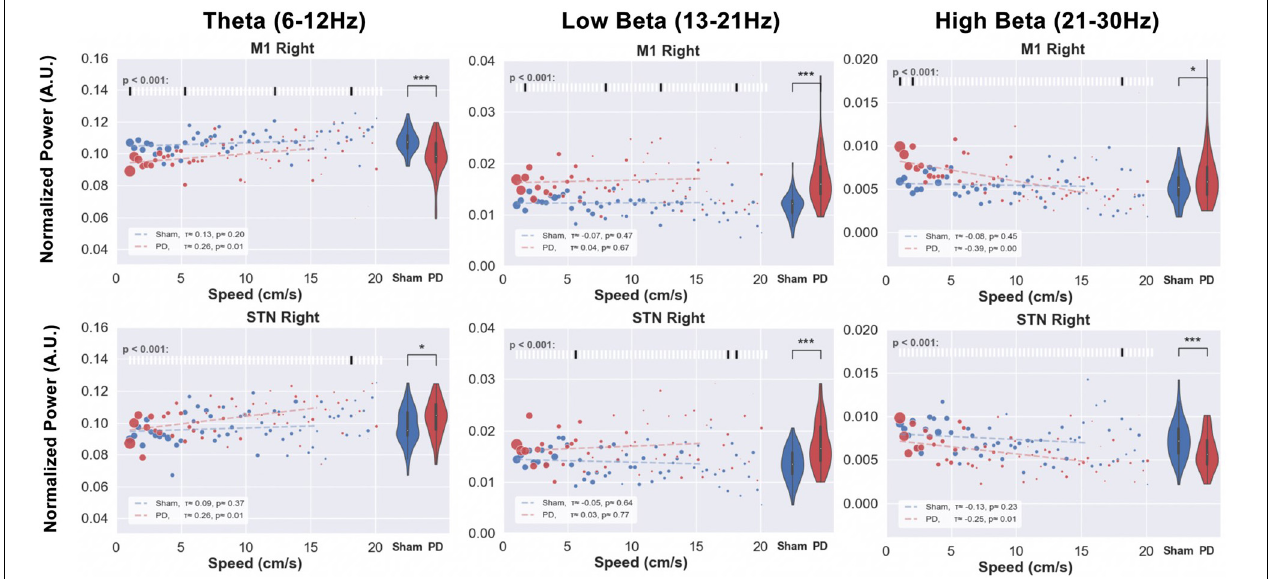
FIGURE 11 | Speed-power relationship was analyzed in order to investigate the correlation between behavioral impairments and electrophysiological indicators. The locomotion speed of each animal was computed using the tracking data. Electrophysiological signals from M1 and STN of the same timestamps were filtered in theta, low, and high beta bands. The scatter plots above illustrate the median value of the band power at each specific speed (red for PD and blue for sham). The size of each point represents the relative amount of data (number of animals exhibiting that speed) per point. The violin plots on the right side of each figure represent the distribution of power over all the speed bins. Kendall’s rank correlation coefficient (x) was computed to assess the correlation between speed and power band values, as shown in the white box in the bottom-left corner of each subfigure. Significance tests between PD and sham band power values at each speed were performed and are shown in the raster plot along the top of each subfigure. Note: Except for the low beta band, PD animals’ LFP power does not exceed healthy animals’ power with the exemption of high beta power at low speeds in the M1. Level of significance: (* p < 0.05 and *** p < 0.001). Figure adapted from Mottaghi